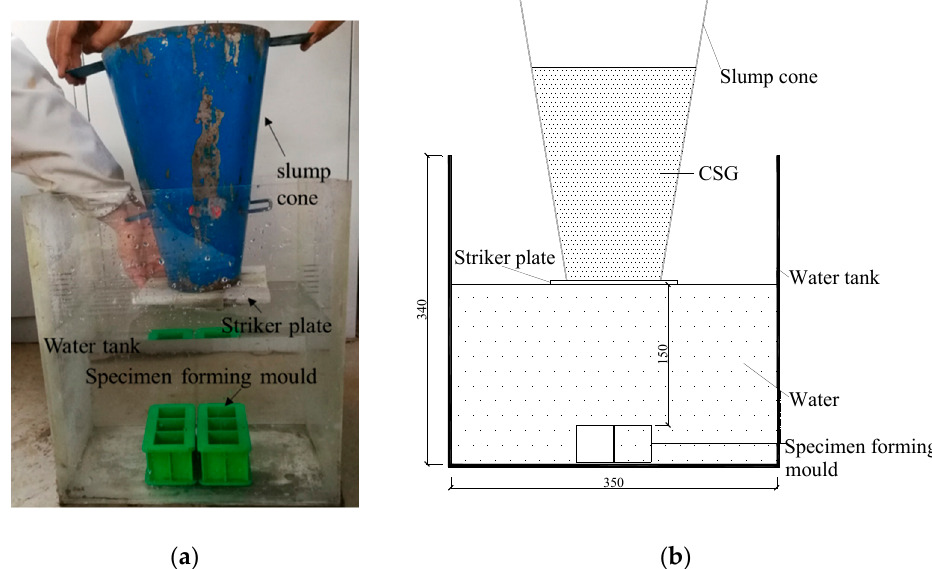
Figure 1. Testing apparatus of CSG in water. ( a ) Photo of test apparatus; ( b ) schematic diagram of apparatus.